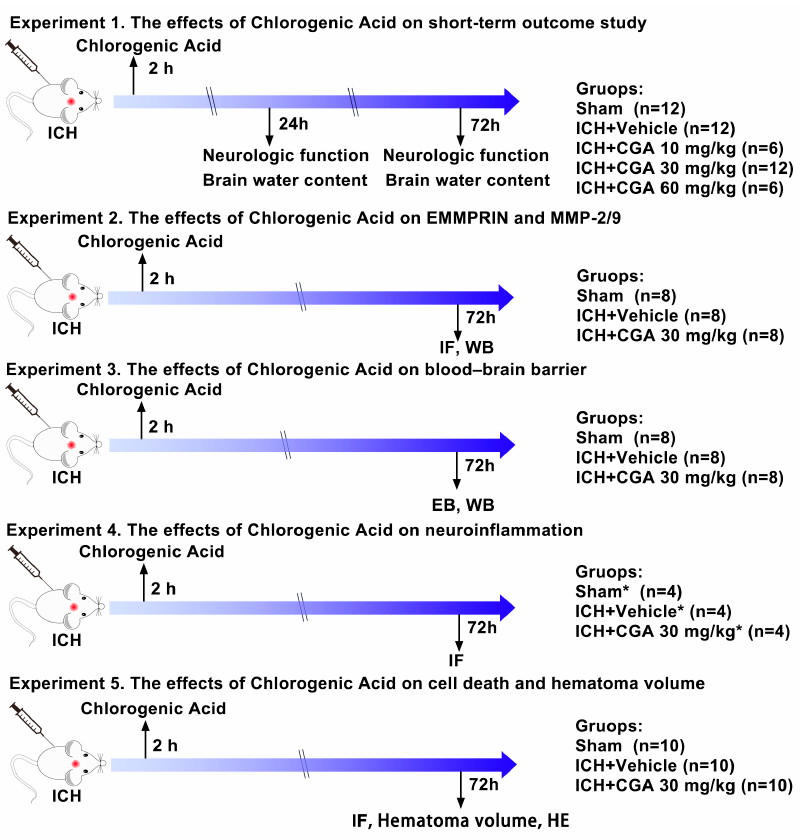
Figure 1. Outline of experimental design. ICH, intracerebral hemorrhage; IF, Immunofluorescence; WB, Western blot; EB, Evans blue; Hematoxylin and Eosin: HE. The asterisk indicates samples shared with experiment 2.